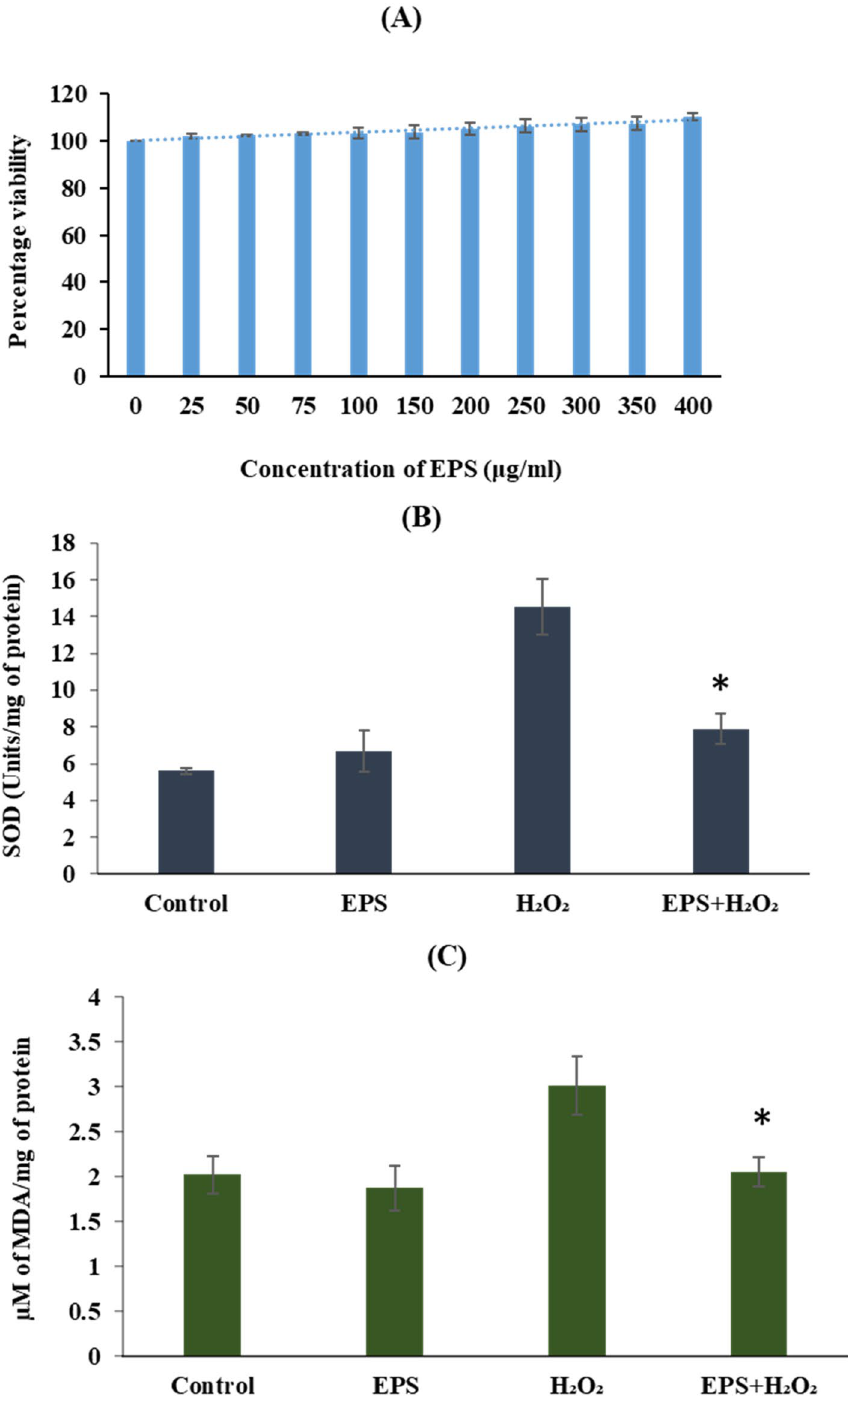
Figure 3. Effect of EPS on yeast and measurement of oxidative stress markers. ( A ) Effect of galactan on the yeast growth: Exponentially grown wild type (WT) cells were treated with different concentrations of galactan overnight. Cells were serially diluted, CFU assay was performed. ( B ) SOD activity: Yeast cells treated with or without EPS for 2 h followed by treatment with or without H 2 O 2 for 1 h and performed SOD activity. ( C ) Lipid peroxidation: Yeast cells treated with or without EPS for 2 h followed by treatment with or without H 2 O 2 for 1 h and carried out lipid peroxidation by TBARS method. Data are mean ± SD of three independent experiments. *represents P < 0.0001 a significant increase/decrease in EPS + H 2 O 2 treated samples compared to those treated with H 2 O 2